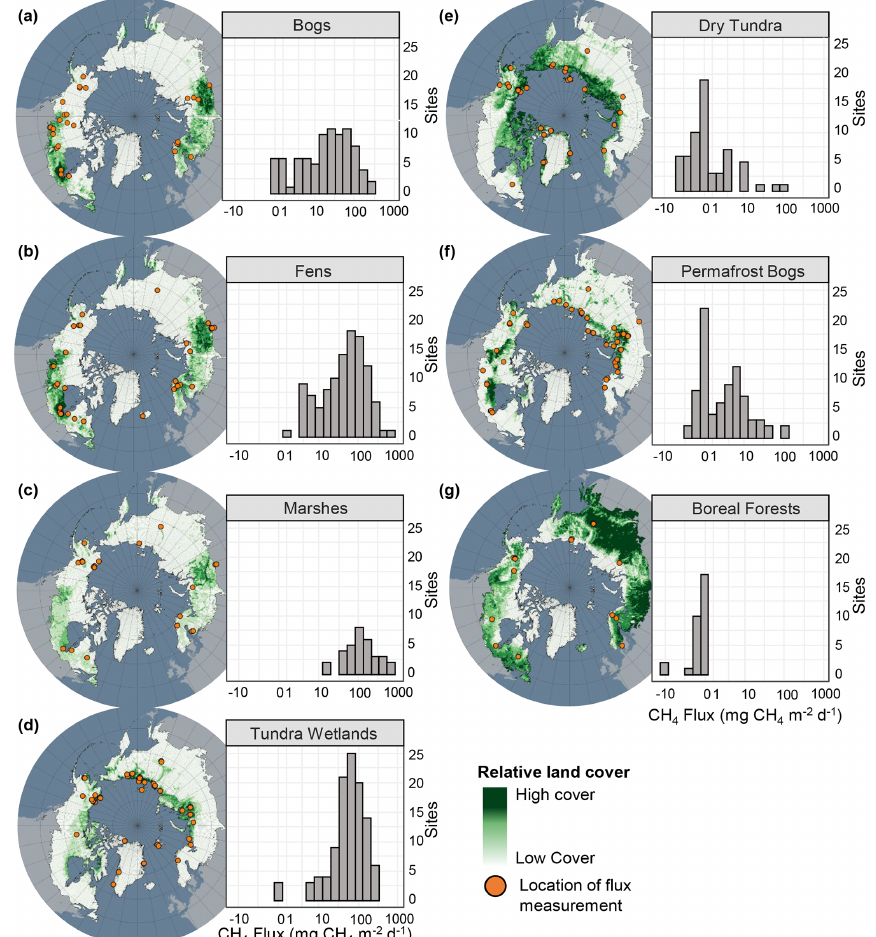
Figure 12. Geographical distribution and flux frequencies and for each terrestrial class. Relative land cover for each type is represented in green on the map. Site locations are represented by orange circles. Note the log scale for CH 4 flux. Land cover distributions from Olefeldt et al. (2021a, b). Histograms of non-transformed flux data can be found in Fig.